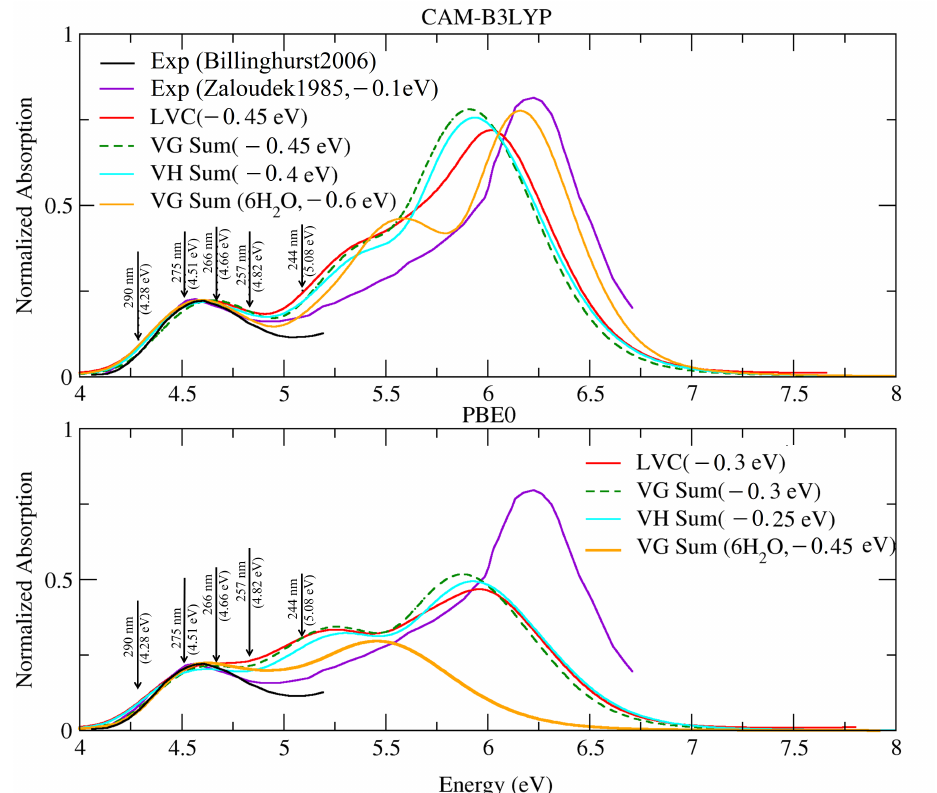
Figure 2. Absorption spectra of cytosine—computed by the LVC model, FC | VG, FC | VH, and FC | VG— which, considering the 6H 2 O effect, convoluted with a Gaussian of HWHM = 0.12 eV and a Lorentzian of HWHM = 0.04 eV. Experimental data, in water, from [35] (black) and [57] (purple). Arrows indicate the excitation wavelength used in the vRR experiments in [35]. For better comparison with the experiments, all spectra were renormalized so as to have the same maximum intensity for the lowest peak. Experimental spectra in [57] are given in (dm 3 mol ´ 1 cm ´ 1 ), and absolute intensities are compared in Figure S5 in the Supplementary Materials, confirming a good